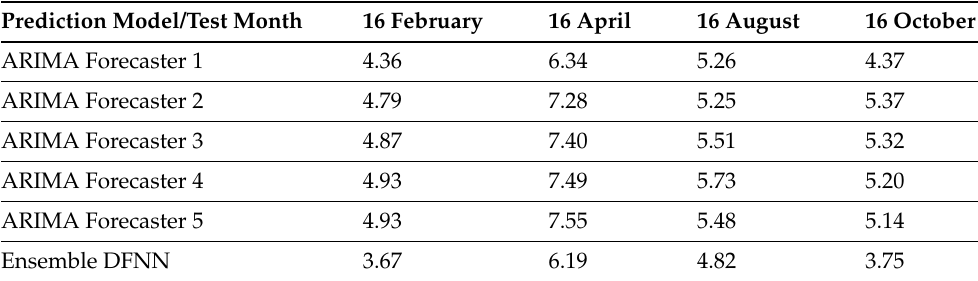
Table 1. One day-ahead NE Load Forecasting results: MAPE (%).